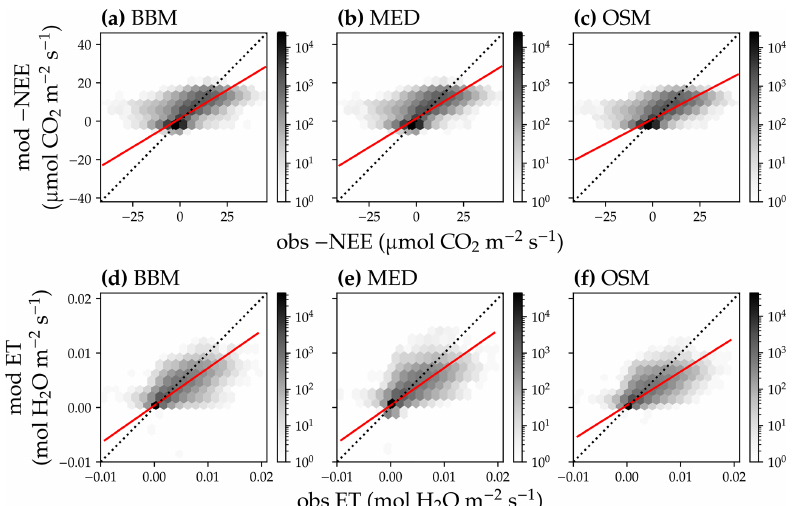
Figure 15. Comparison of modeled and observed carbon and water fluxes for the three stomatal models when fitting an extra empirical model stomatal model parameter for the US-MOz (MOFLUX, deciduous angiosperm forest) flux tower site. (a) Comparison of modeled ( y axis) and observed ( x axis) net ecosystem carbon flux (NEE) for the Ball et al. (1987) stomatal model (BBM). Shading represents density: the darker the hexagon, the more data that fell within the hexagon. The red solid line plots the linear regression of the data, and the black dotted line plots the 1 : 1 line. (b) Comparison of NEE for the Medlyn et al. (2011) model (MED). (c) Comparison of NEE for the Wang et al. (2020) model (OSM). (d) Comparison of ecosystem water flux (ET) for BBM. (e) Comparison of ET for MED. (f) Comparison of ET for the OSM. This figure differs from Fig. 13 in that g 1 s (Eqs. 6, 7) for the BBM and MED are also